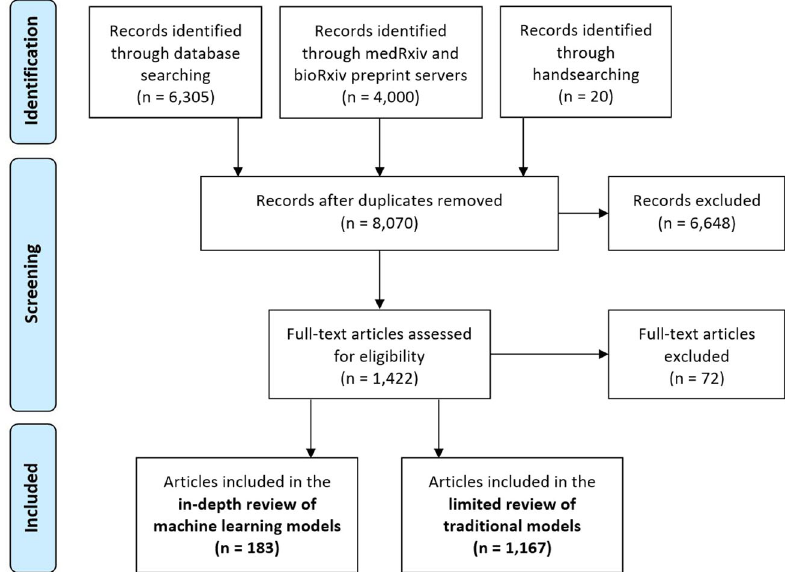
Fig. 1 Study selection fl ow diagram. Modi fi ed Preferred Reporting Items for Systematic Reviews and Meta-Analyses (PRISMA) fl ow diagram showing disposition of